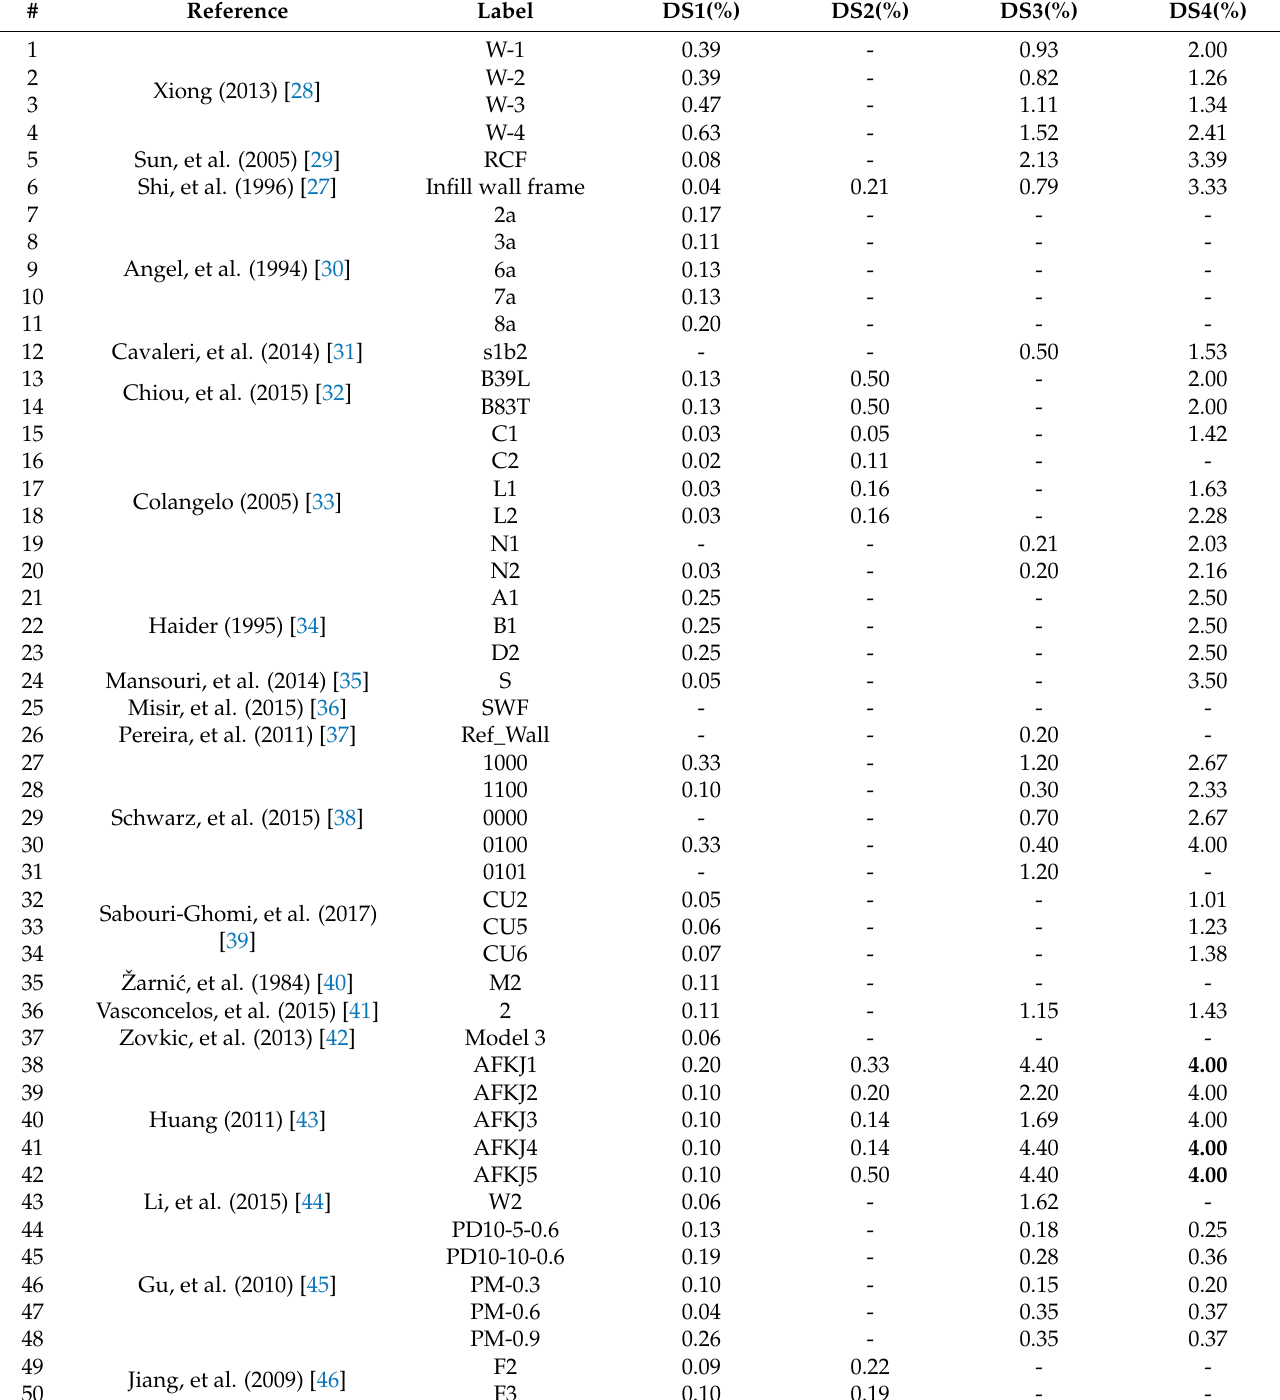
Table 4. IDR values at each